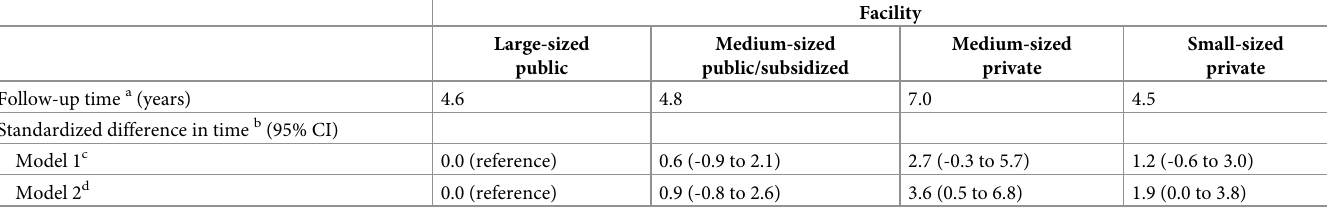
Table 3. Standardized differences in median survival time by type of facility among institutionalized residents in Madrid, Spain, 1998–1999 to